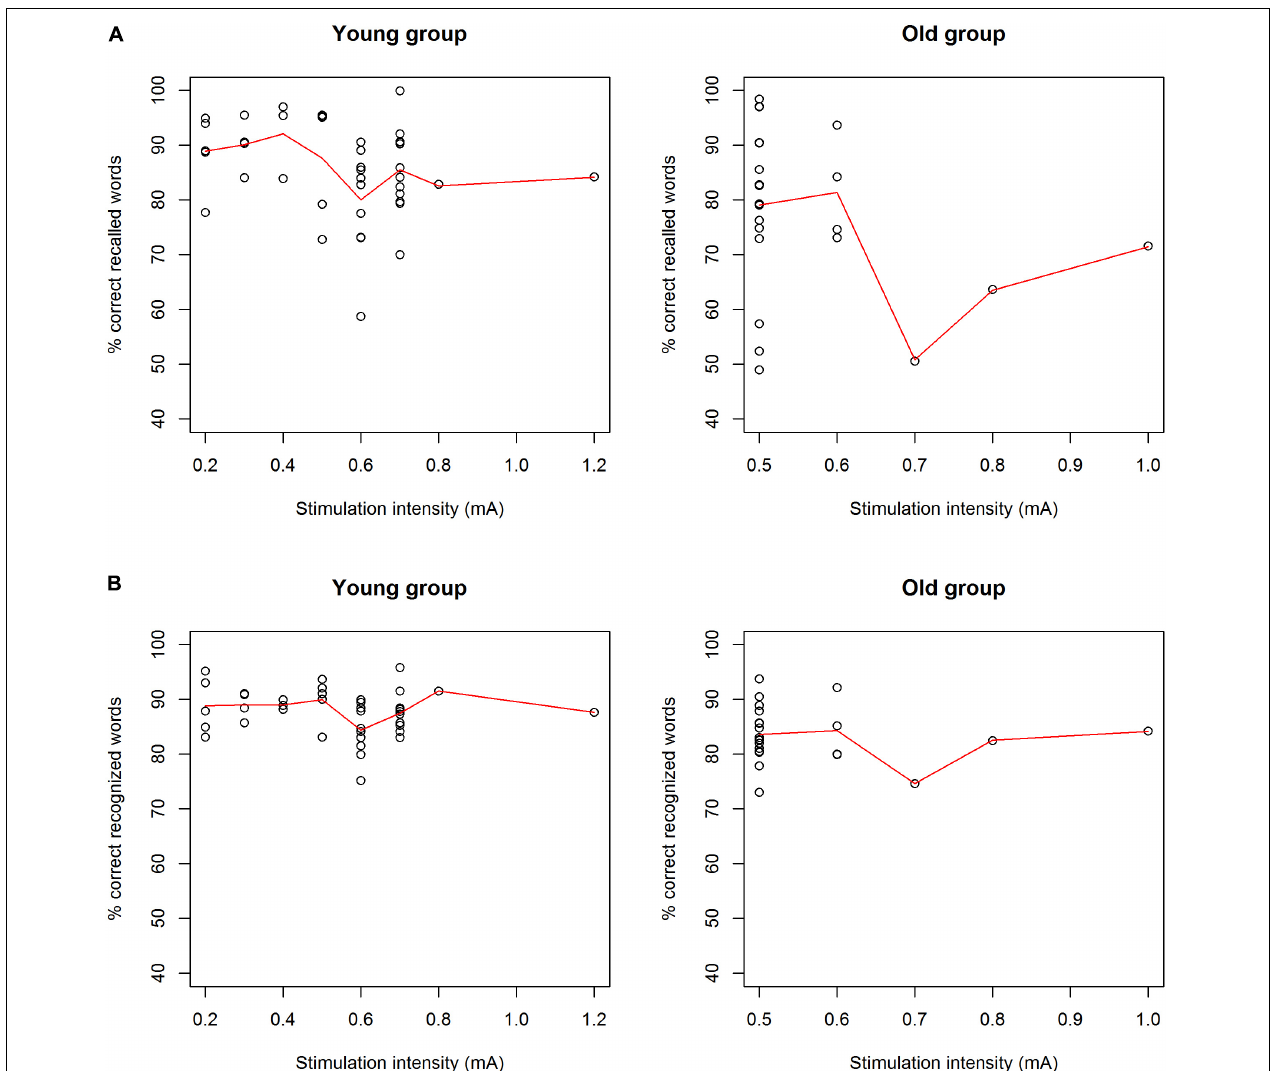
FIGURE 4 | (A) Correlation between immediate recall scores and stimulation intensity for the young group (left) and the old group (right). There was no correlation between stimulation intensity and immediate recall scores in both age groups. (B) Correlation between delayed recognition scores and stimulation intensity for the young group (left) and the old group (right). There was no correlation between stimulation intensity and delayed recognition scores in both age